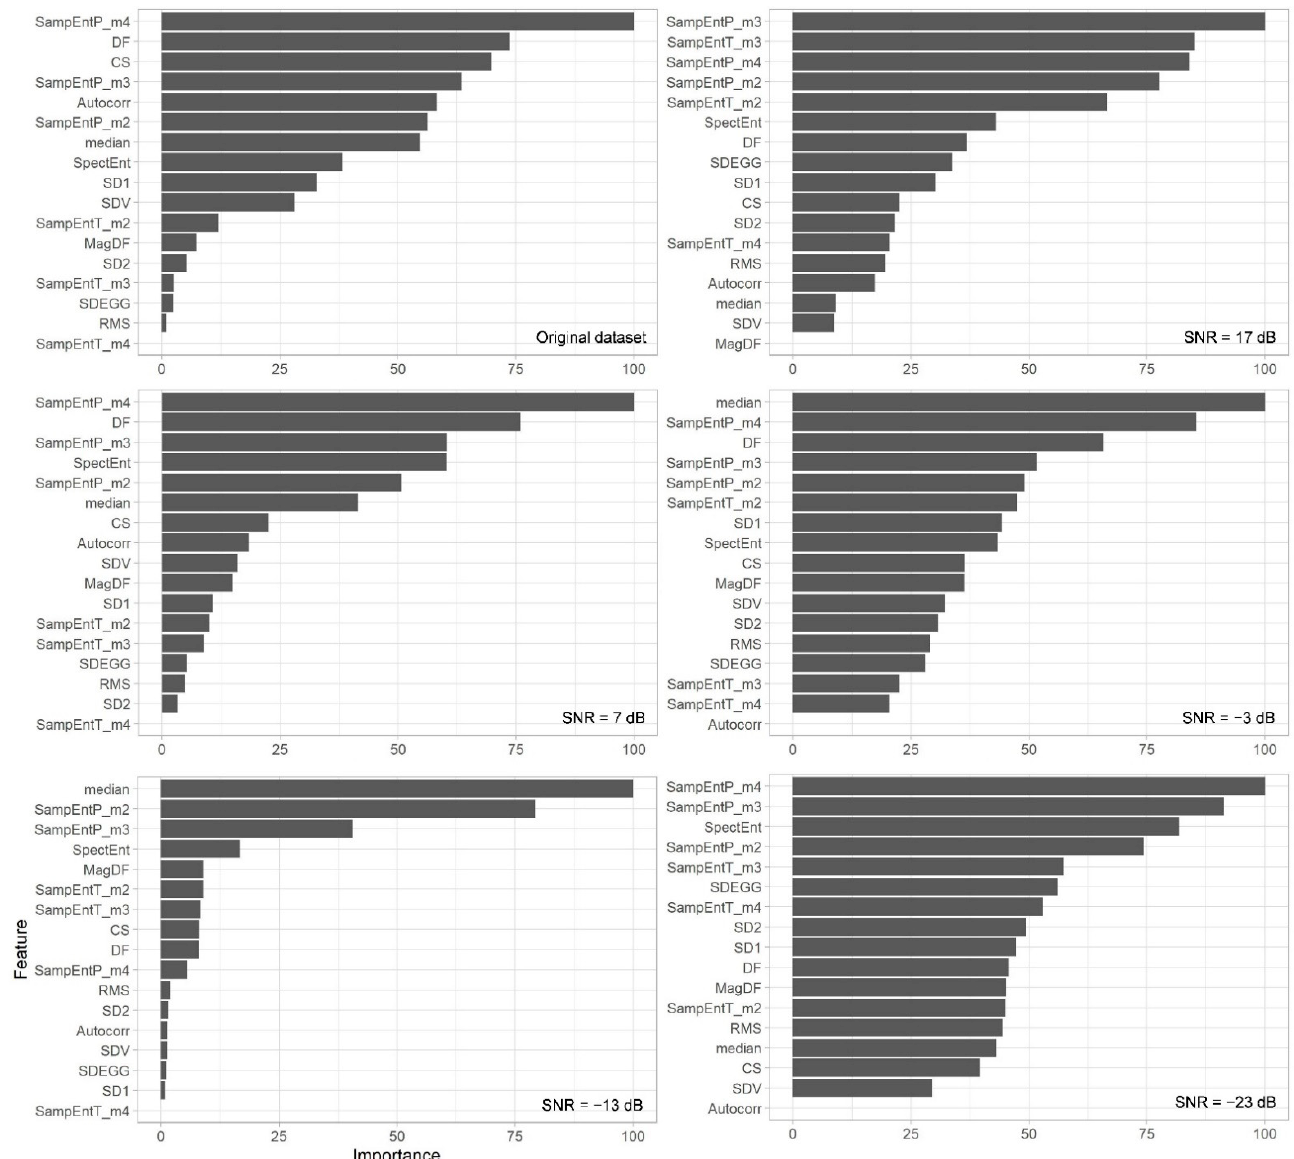
Figure 3. Importance plots for original and noisy datasets with different SNRs as a result of RF binary classifier for nausea detection. SNR stands for Signal-to-Noise Ratio. classifier for nausea detection. SNR stands for Signal-to-Noise